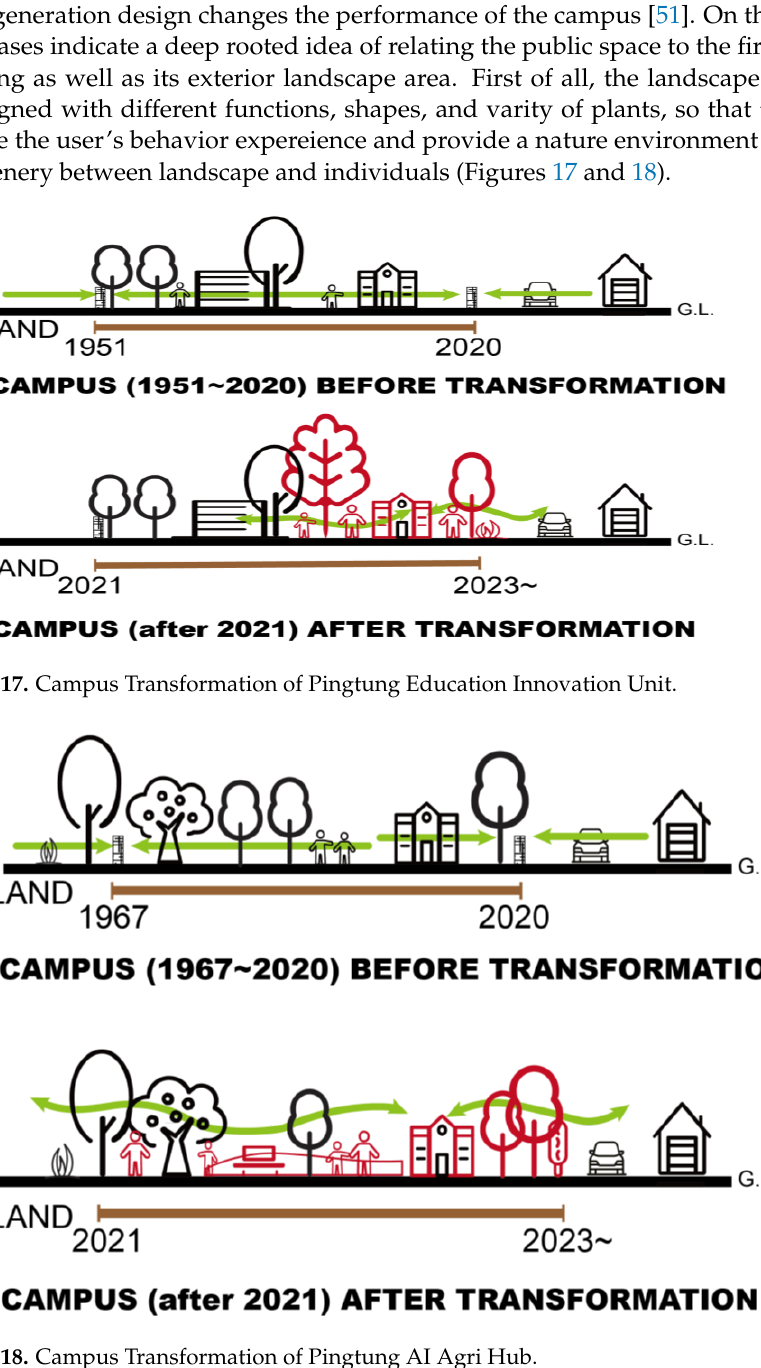
Figure 16. Pingtung AI Agri Hub Territory Order Diagram: First Floor Plans. ( a ) Second Floor Plans Before Redesign. ( b ) Second Floor Plans After Redesign.